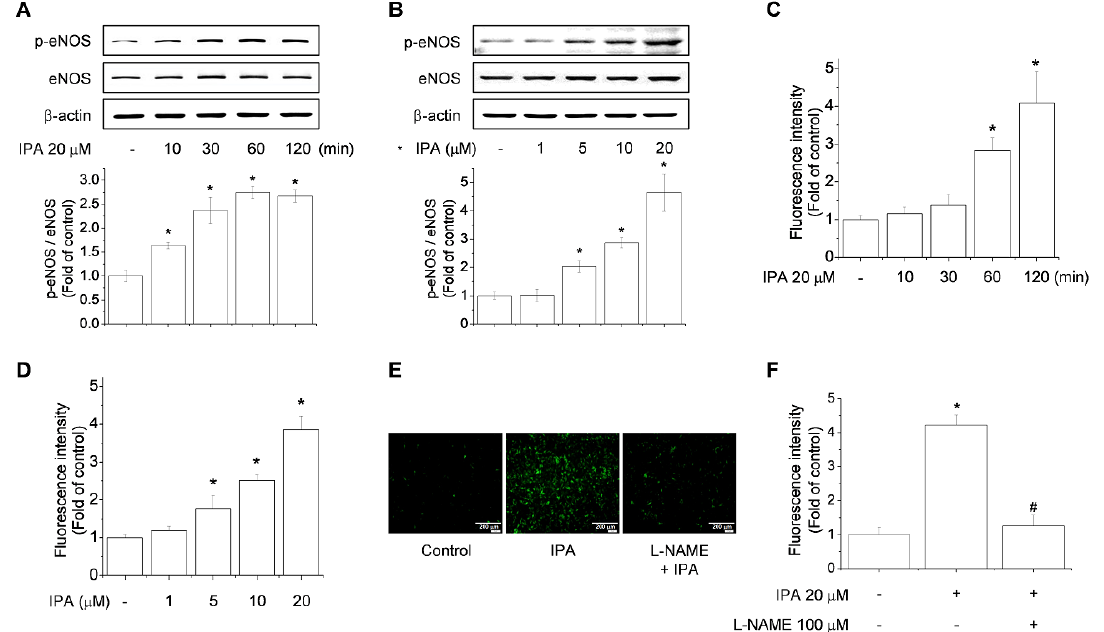
Figure 2. IPA treatment induces endothelial nitric oxide synthase (eNOS) activity and NO production. EA.hy926 cells were treated with 20 μM IPA for 10, 30, 60, and 120 min ( A , C ) or 1, 5, 10, and 20 μM IPA for 60 min ( B , D ), and assessed by western blotting ( A , B ) or measured using the NO-specific fluorescent dye 4,5-Diaminofluorescein diacetate (DAF-2 DA) at 495/515 nm ( C , D ). Cells were pretreated with 100 μM L -NAME (NOS inhibitor) for 60 min before treatment with 20 μM IPA for 60 min at 37 °C, and NO production was visualized and measured using the NO-specific fluorescent dye DAF-2 DA at 495/515 nm ( E , F ). Data are means ± SD of three independent experiments. * p < 0.05 compared with control. # p < 0.05 compared with IPA treatment.